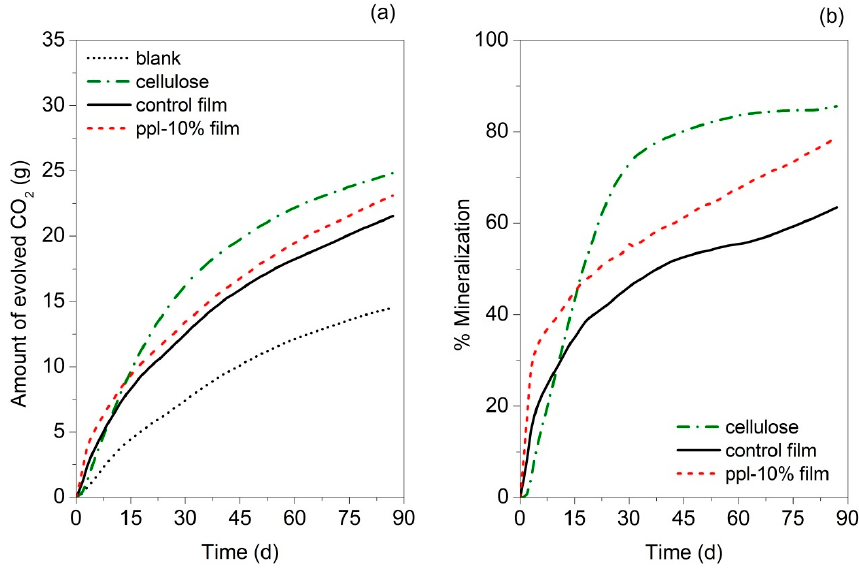
Figure 8. ( a ) Amount of evolved CO 2 of control and active films, cellulose and blank compost; ( b ) %Mineralization of control and active films and cellulose, at 58 ± 2 °C and approximately 50 ± 10% RH in yard waste compost.